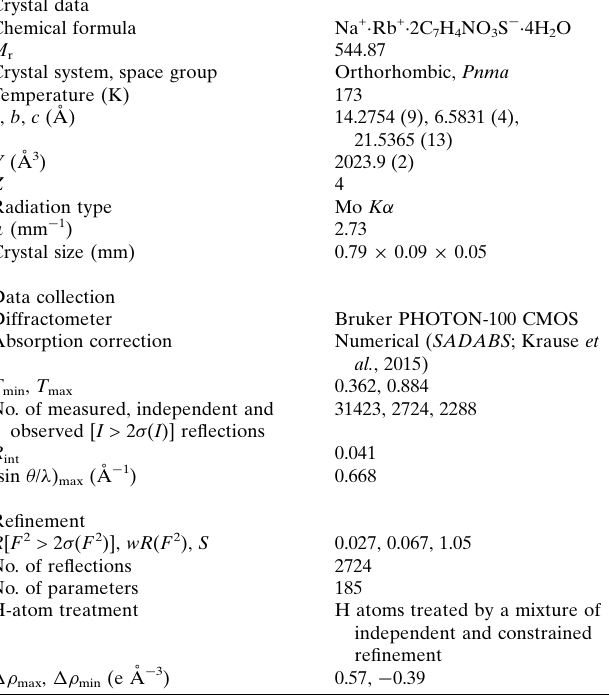
Table 3 Experimental details. Crystal data Chemical